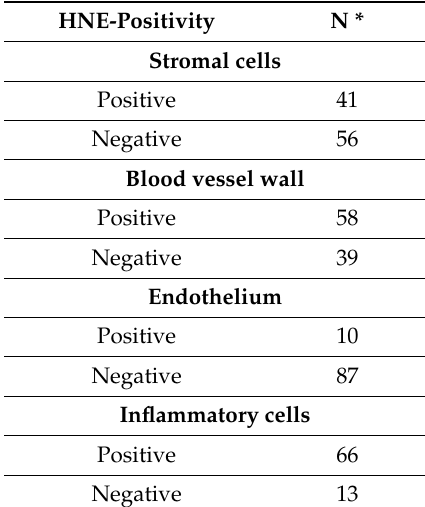
Table 2. The presence of HNE-immunopositivity in non-malignant tissue cells within/near tumor. HNE-Positivity